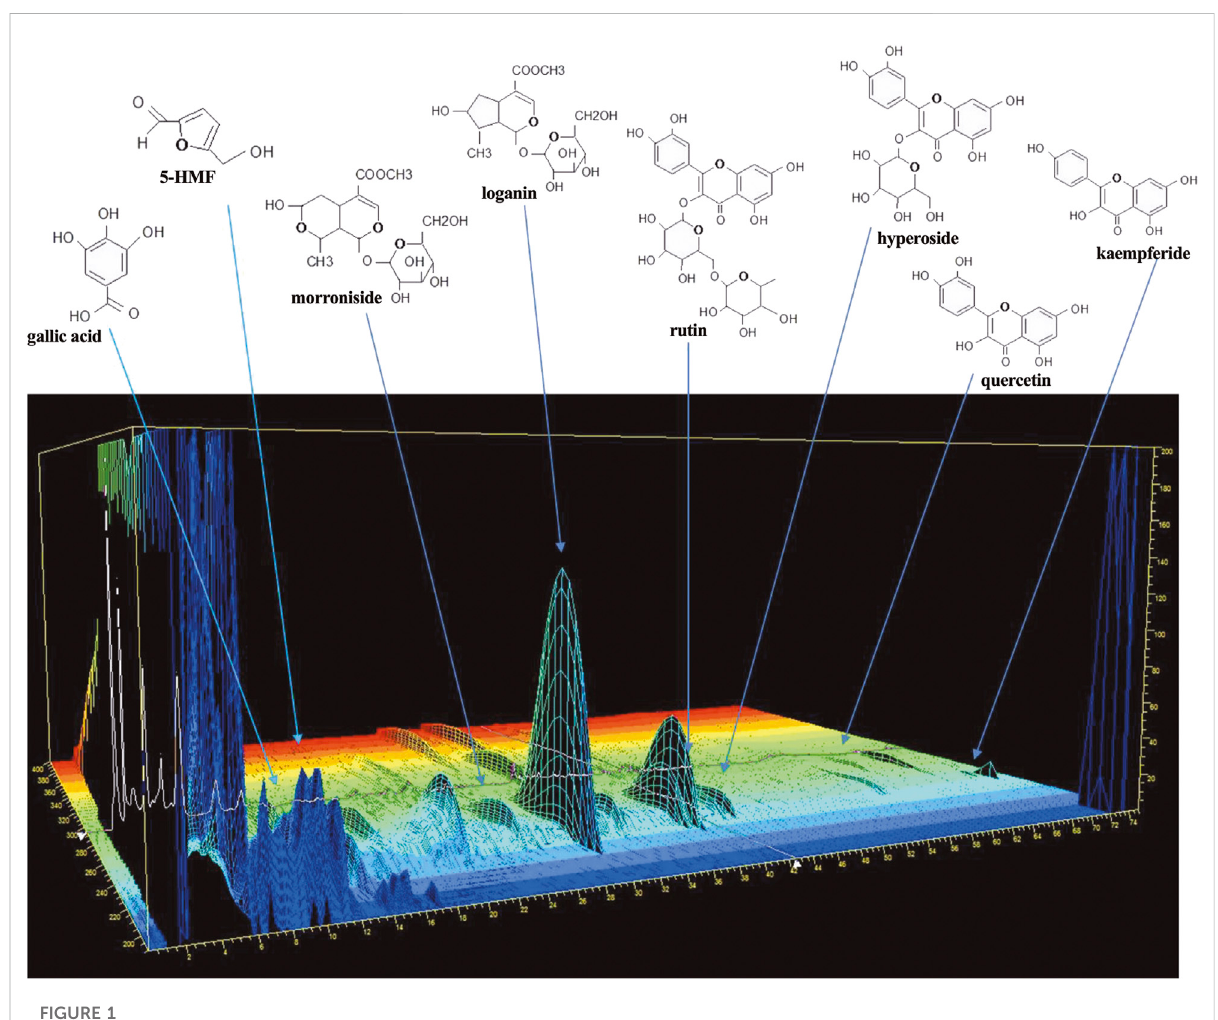
FIGURE 1 Three-dimensional HPLC pro fi le of Zuogui